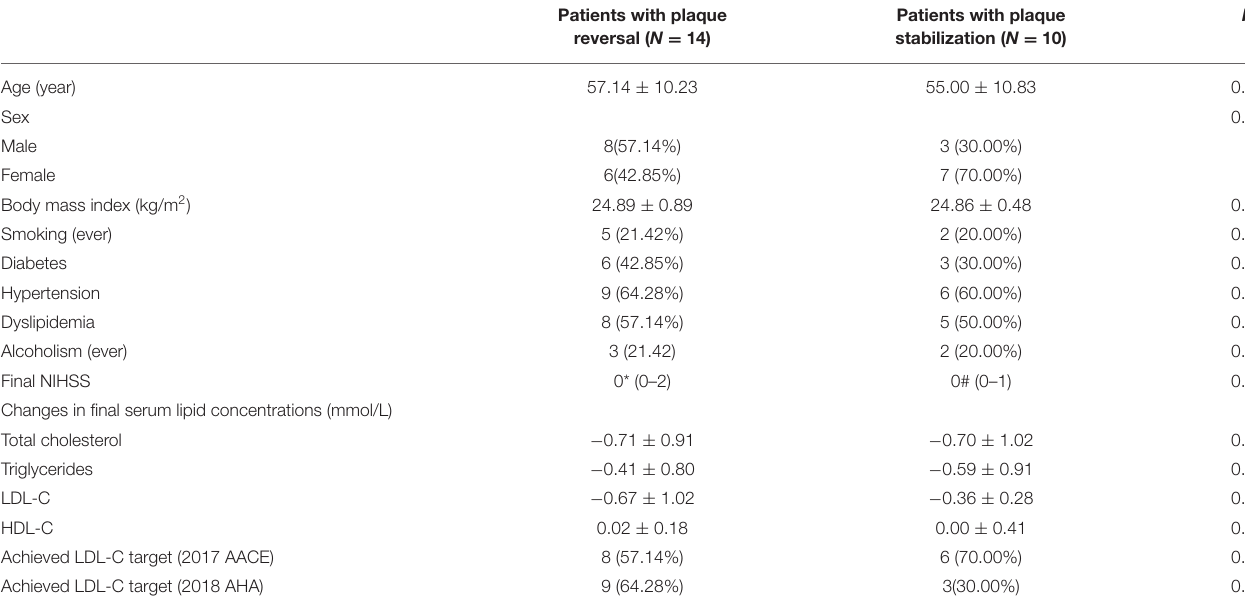
TABLE 4 | Clinical information of patients with different plaque properties at the follow-up endpoint.